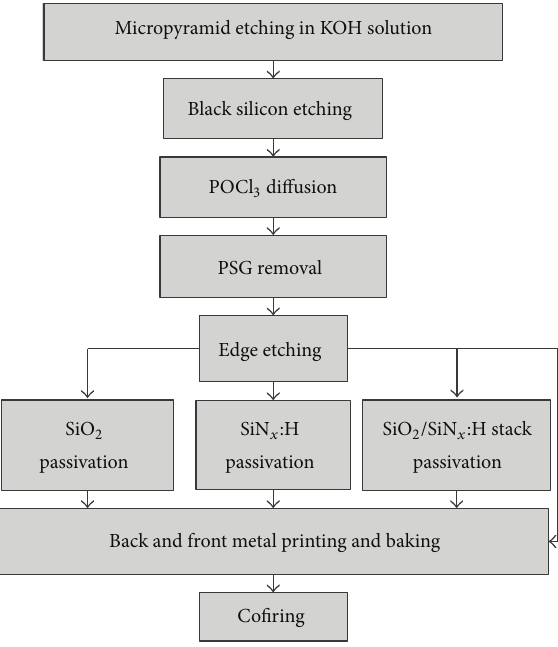
Figure 1: Fabrication process flow chart of the b-Si solar